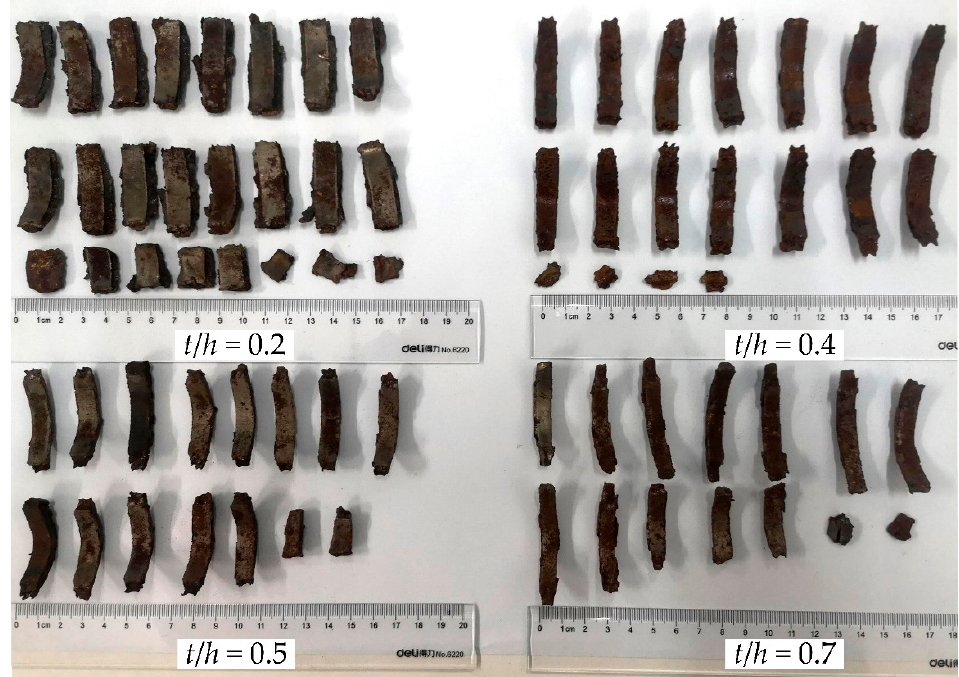
Figure 18. Recovered fragments generated from the grooved shell with varied ratios of groove depth t to wall thickness h .